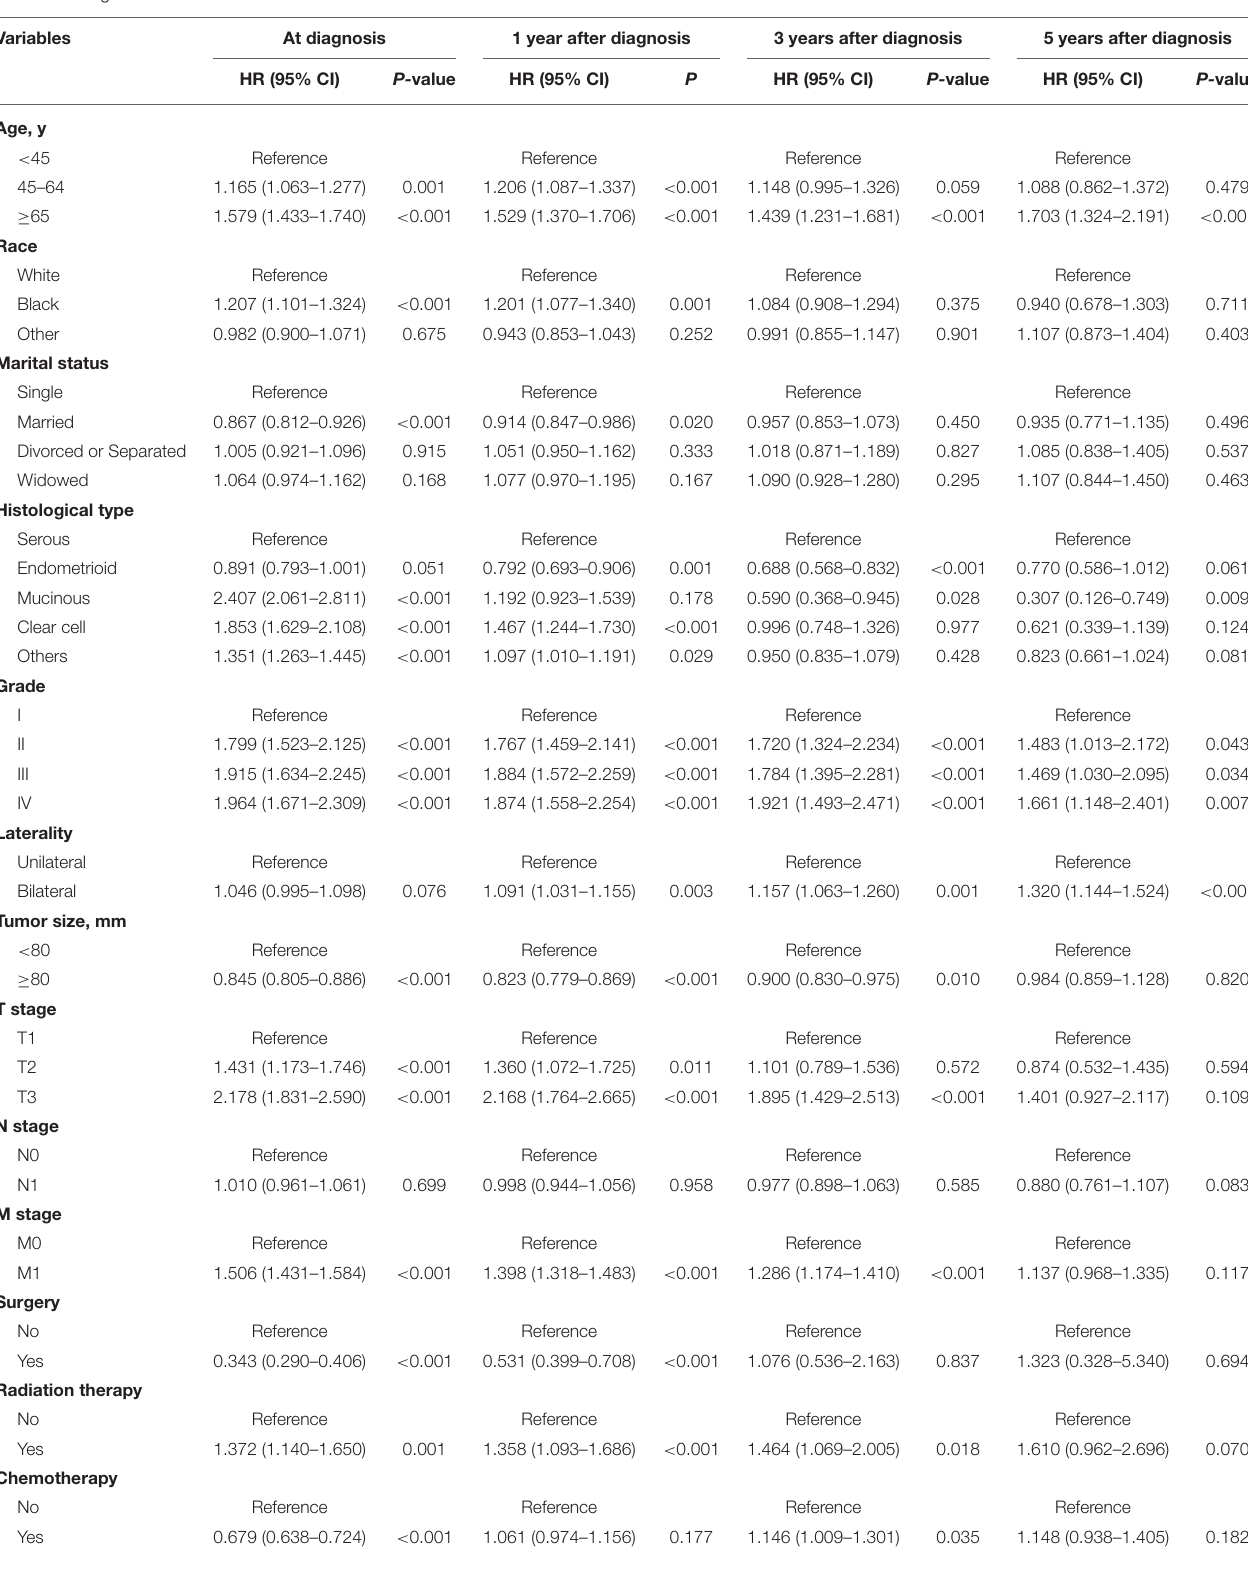
TABLE 3 | Cox proportional hazards regression analyses of overall survival at the time of diagnosis and conditional survival for advanced EOC survivors at 1, 3, and 5 years after